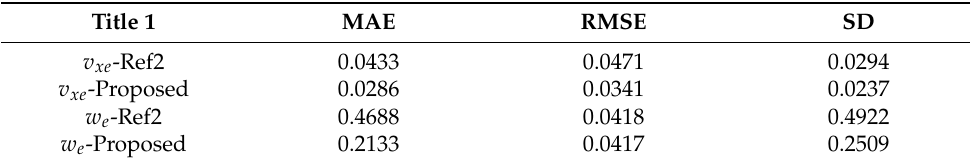
Figure 16. Yaw rate tracking error.